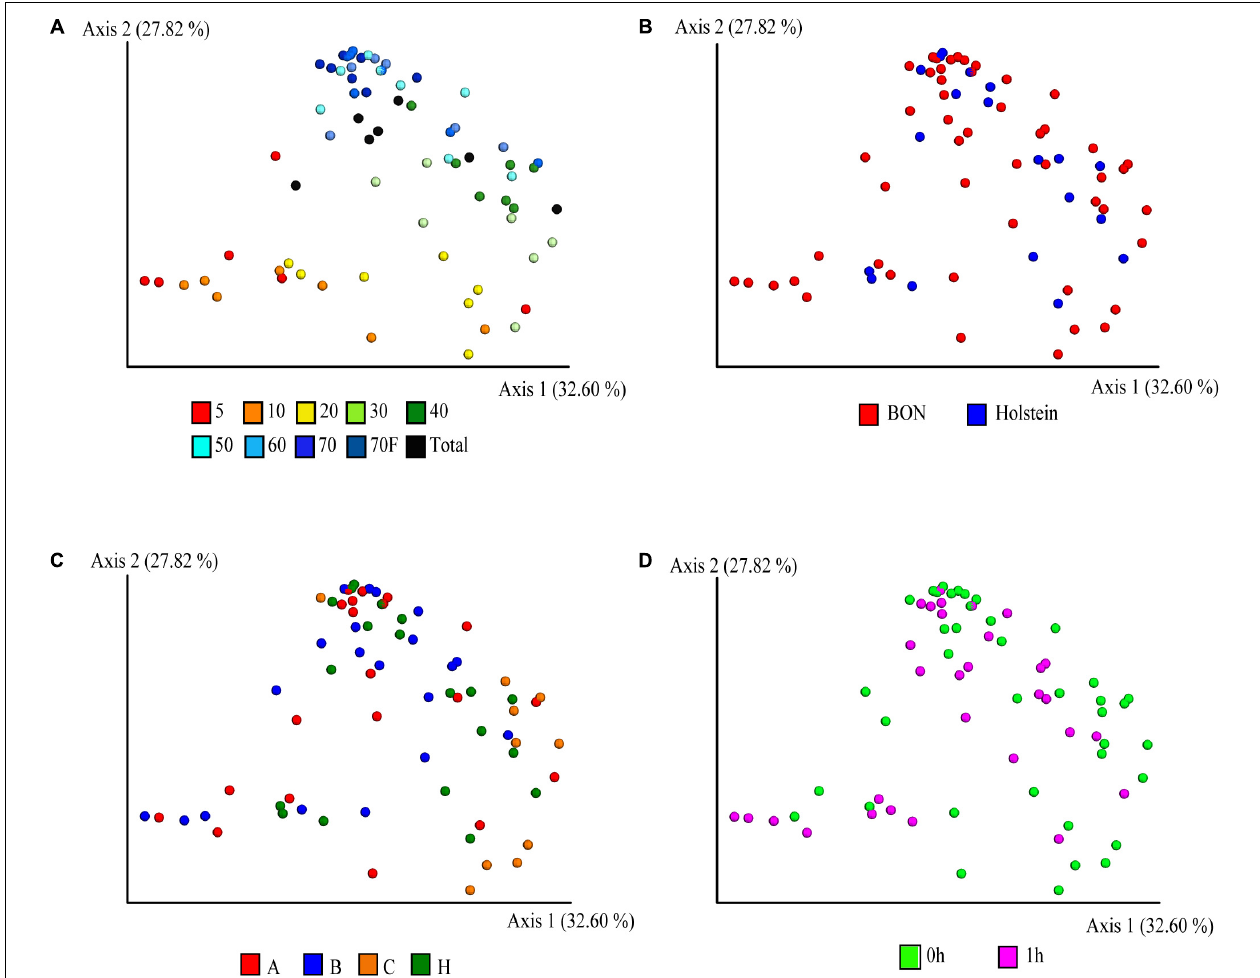
FIGURE 2 | Principal coordinate analysis (PCoA) of the fractionation of the ruminal microbial community based-on weighted UniFrac distances. Distribution of the community in the samples is depicted according to (A) sucrose concentration, (B) breed, (C) animals, where A, B, C, and H represent BON-A, BON-B, BON-C, and Holstein respectively, and (D) sampling at fasting and post